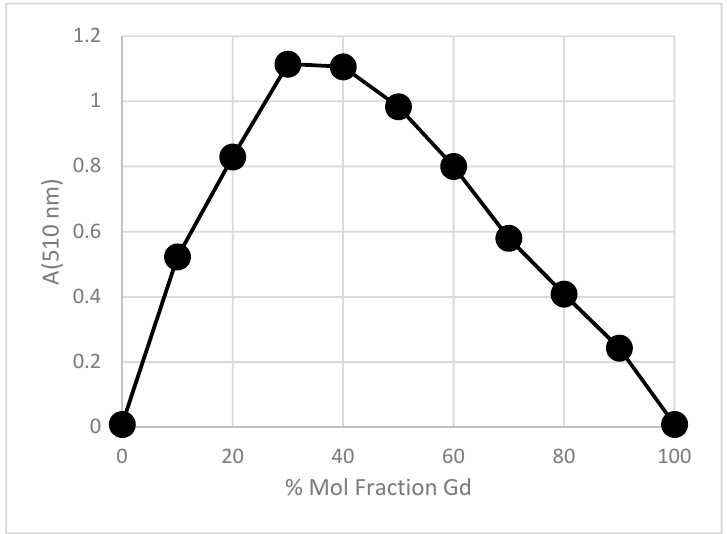
Figure 2. Results for the method of continuous variation in 0.100 M TEA buffer pH 8. The total concentration of PAR and Gd 3 + was fixed at 1 × 10 − 4 M. The position of maximum absorbance (~35 ± 3%) is consistent with a 1:2 Gd 3 + : PAR ratio for the complex.